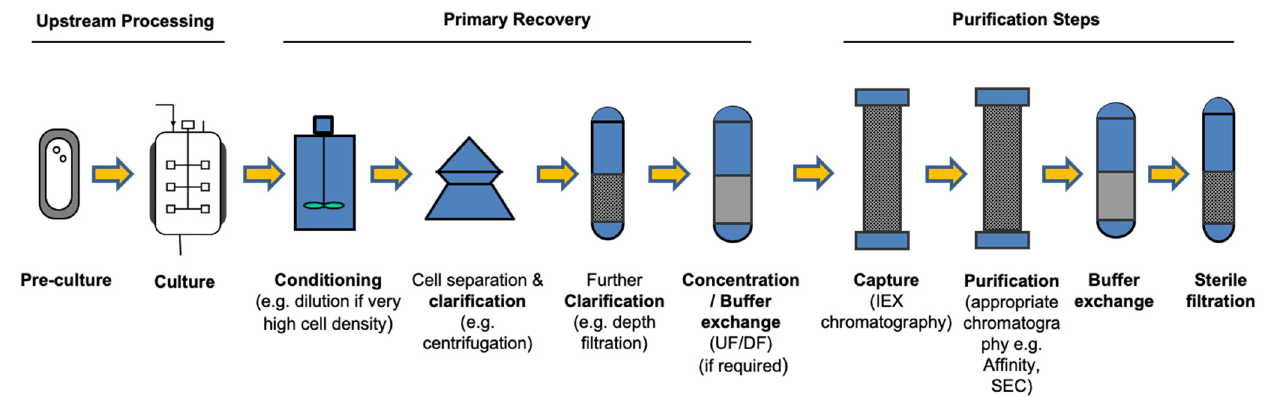
Figure 3. Schematic Overview of a potential process for secreted product.